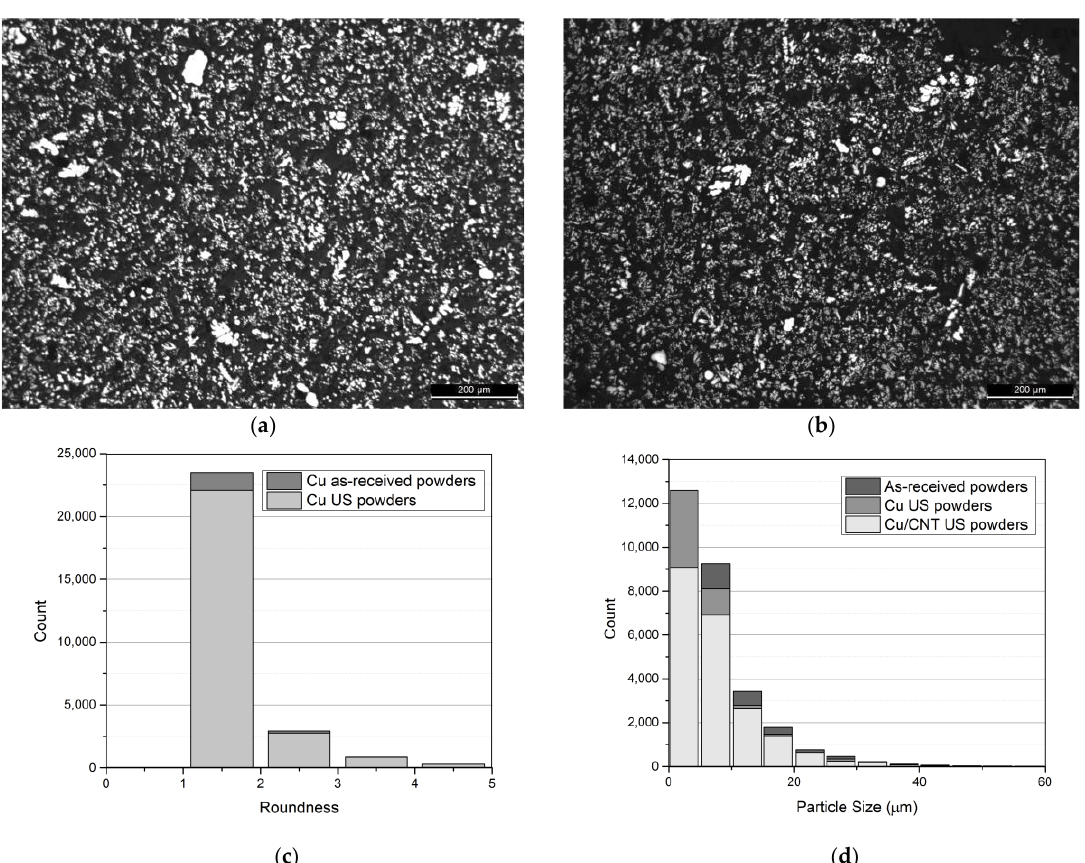
Figure 3. ( a , b ) OM images of as-received and dispersed Cu powders and ( c ) roundness distribution of the particles, and ( d ) particle size distribution, for as-received and dispersed Cu (US: Ultrasonication) and Cu/CNTs powders.